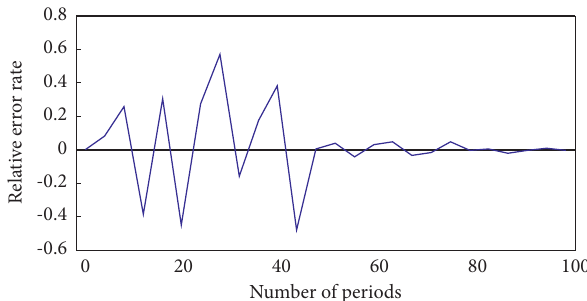
Figure 6: Dynamic variation of relative error rate with different periods. Figure 6. According to the variation law of model residuals in different periods, although the random interference term of the model can basically meet the same variance condition, the relative error rate will decrease with the increase of the prediction target value of the model. The relative error rate of the model prediction is large in the early stage but small in the later stage.